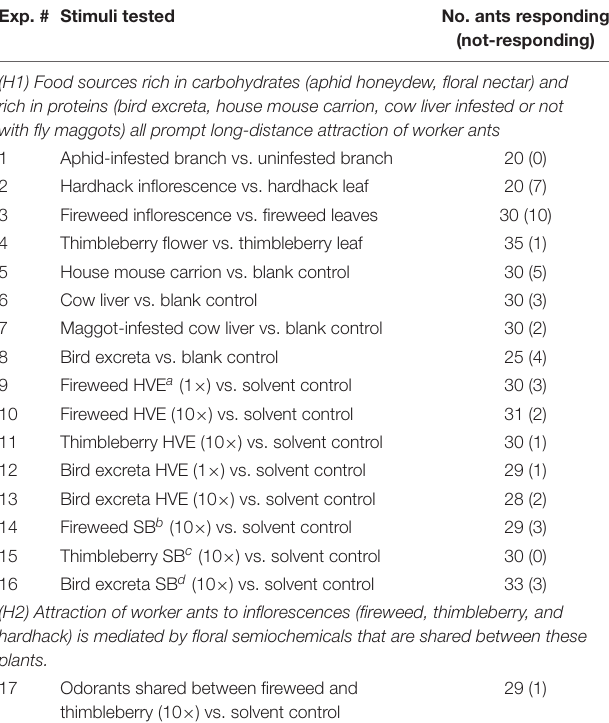
TABLE 1 | Stimuli tested with Camponotus modoc ants in experiments